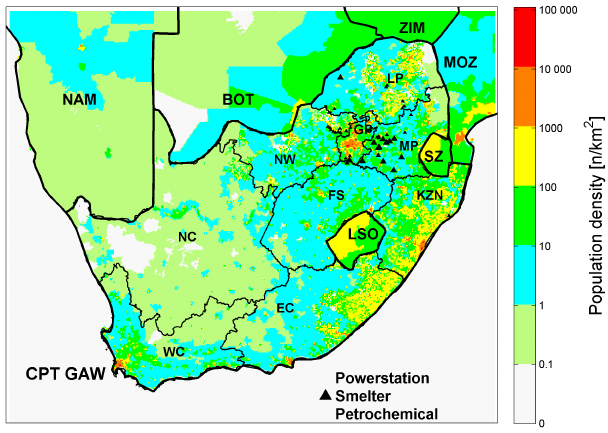
Figure 1. Position of CPT GAW within a regional context. The pop- ulation density (people perkm 2 ) provides an indication of the pos- sible location of anthropogenic pollution sources, while the location of large anthropogenic point sources (e.g. coal-fired power stations, metallurgical smelters and petrochemical plants, adapted from Ven- ter et al., 2012 and Lourens et al., 2011, 2012) is also indicated. NAM = Namibia, BOT = Botswana, ZIM = Zimbabwe, MOZ = Mozambique, SZ = Swaziland, LSO = Lesotho, WC = Western Cape, EC = Eastern Cape, NC = Northern Cape, NW = North West, FS = Free State, KZN = KwaZulu-Natal, GP = Gauteng, MP = Mpumalanga and LP =